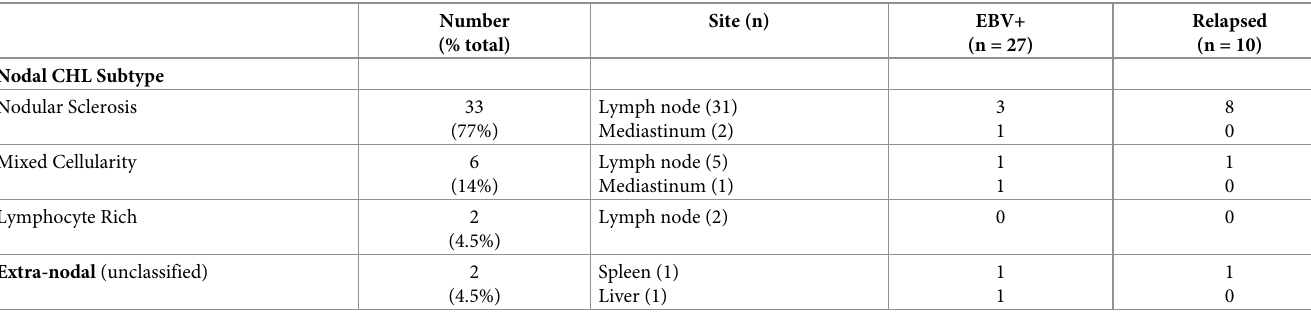
Table 1. Summary of